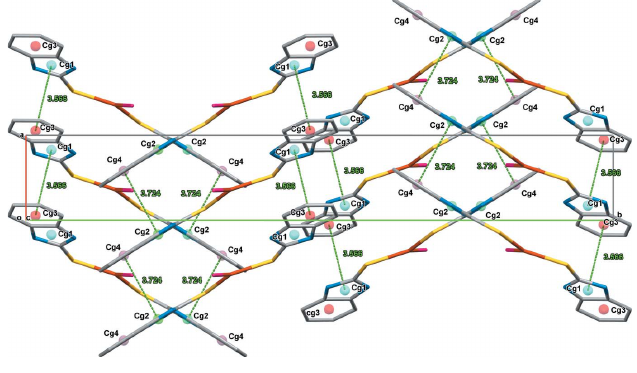
Figure 4 The intermolecular (cid:2) – (cid:2) interactions in the crystal packing of ( 1 ) plotted down the c axis.